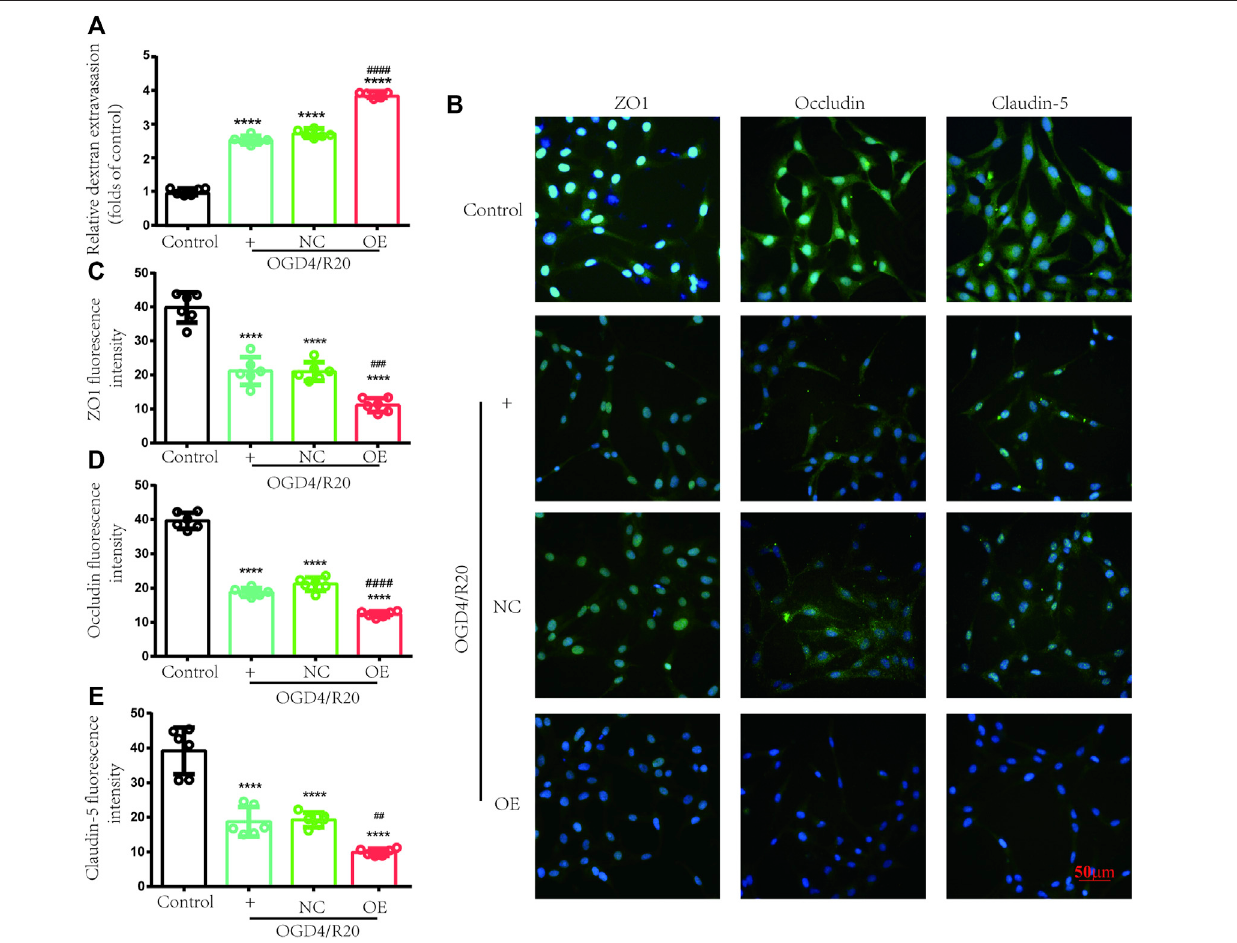
FIGURE 8 | Increasing lncRNA ENST00000530525 deteriorated transendothelial permeability under OGD/R condition. (A) FITC-dextran leakage was used to quanti fi cat transendothelial permeability. (B – E) Representative immuno fl uorescence indensity of ZO-1, occludin and claudin-5. Scale bar: 50 μ m. NC: negative control; OE: over expression; OGD4/R20: 4 h of OGD and 20 h of reoxygenation. **** p < 0.0001 (vs. Control); # p < 0.001, ## p < 0.01; ### p < 0.001, #### p < 0.0001 (vs. NC), n = 6, one-way